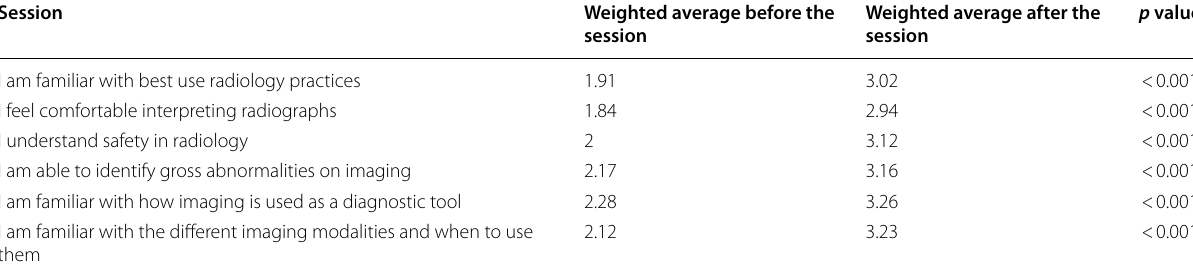
Table 3 Statistical analysis of the confidence level of the students before and after the sessions Session Weighted average before the